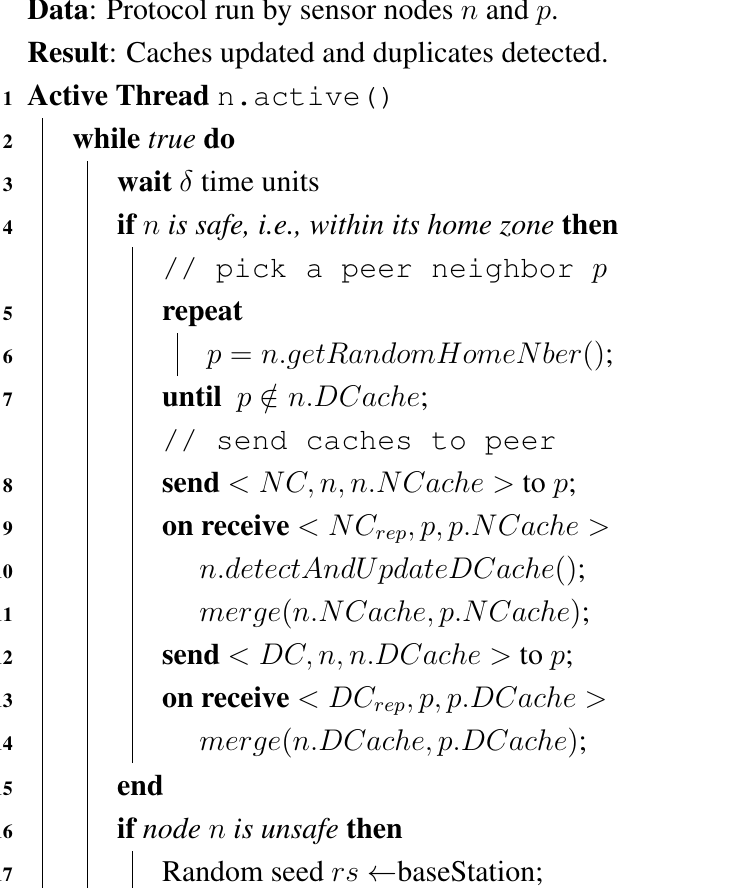
Algorithm 1: Discard duplicate detection protocol: active thread. Data : Protocol run by sensor nodes n and p